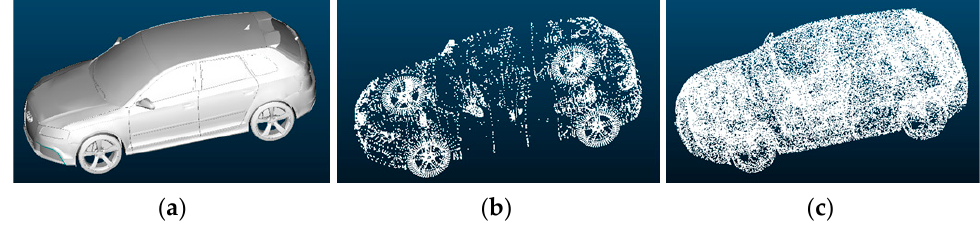
Figure 5. An example of the graphical representation of a CAD model. ( a ) Mesh, ( b ) mesh vertices: 17,815, and ( c ) resampled points: